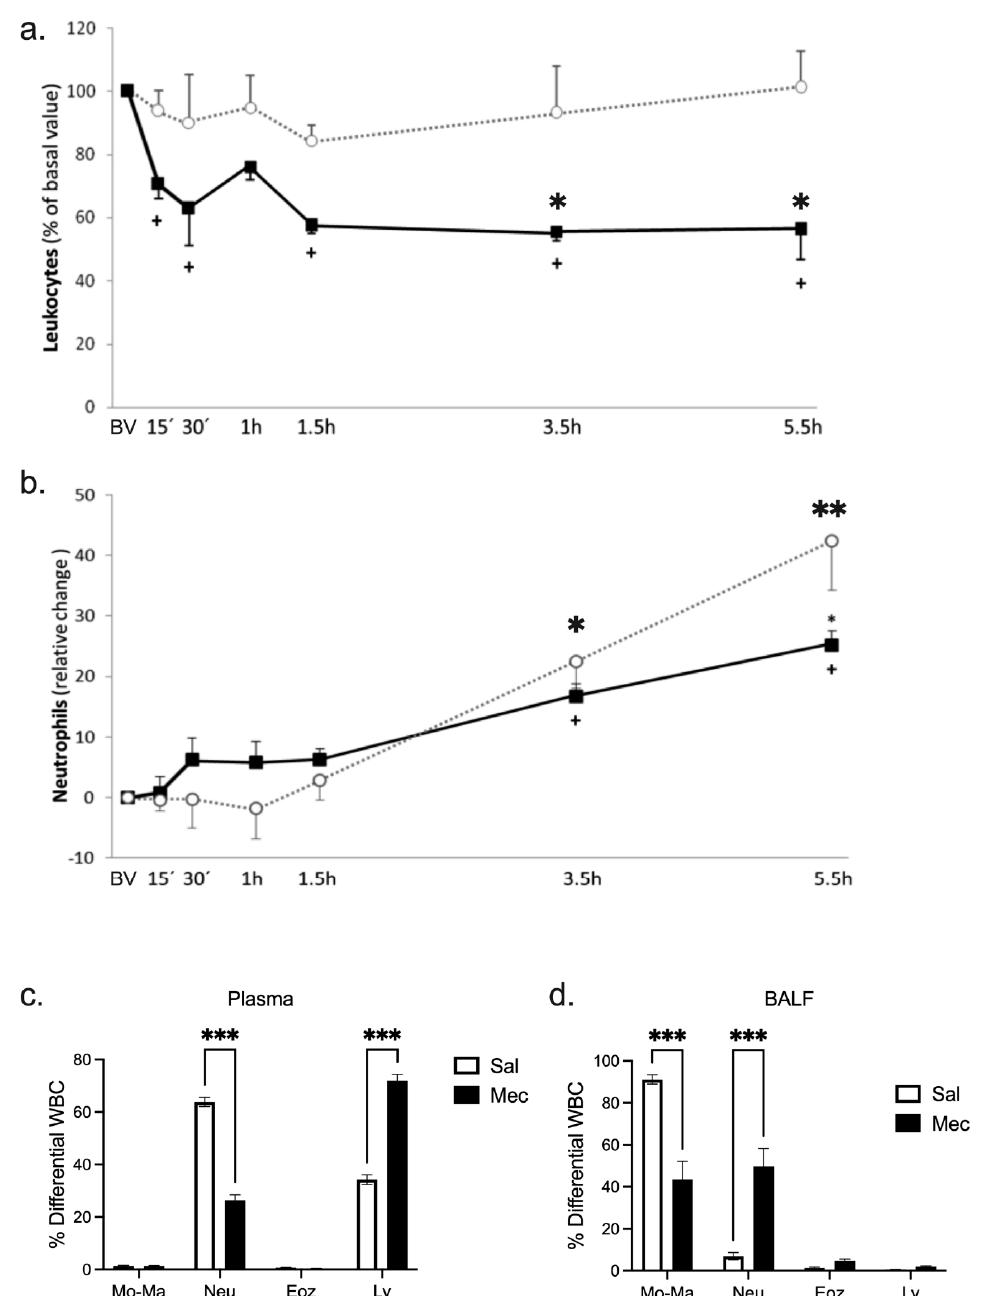
Figure 3. Total and differential leukocyte count. ( a ) Leukocyte and ( b ) neutrophil changes in blood in the saline group (open circles) and the meconium group (closed squares); ( c , d ) percentage of differential leukocytes in arterial blood and BALF. Abbreviations: neutrophils (Neut), lymphocytes (Ly), macrophage monocytes (Mo ‐ Ma), eosinophils (Eoz). Statistical comparisons for Mec vs. Sal * p < 0.05, ** p < 0.01, *** p < 0.001; + p < 0.05 vs. meconium basal value (BV).